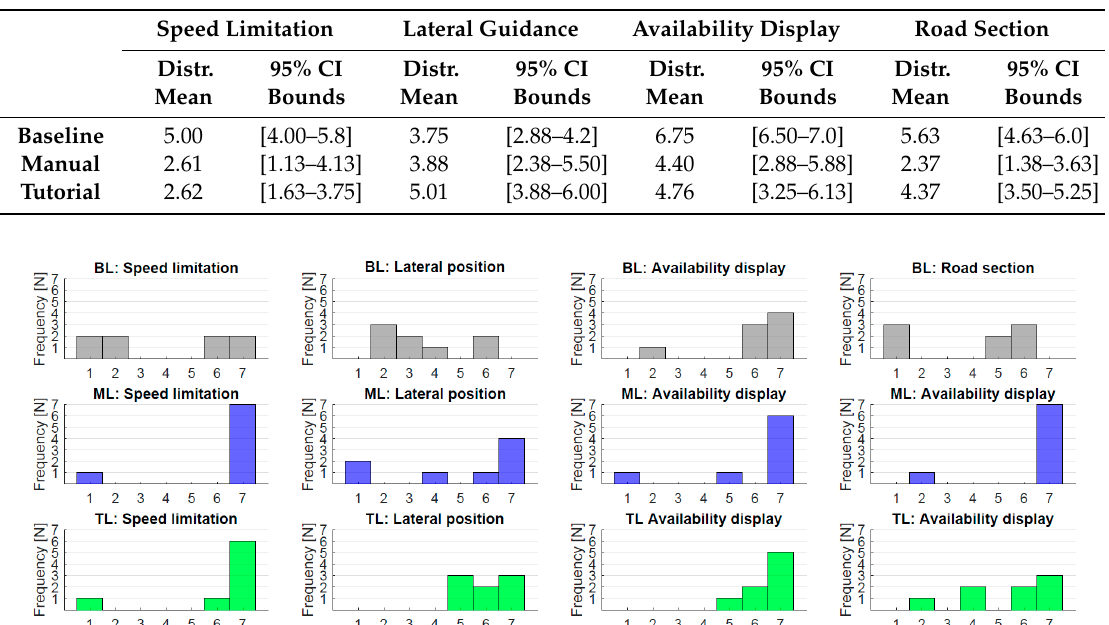
Table 7. Means and 95% CI upper and lower bounds of bootstrapped mental model distributions for the four relevant items on L2 automation by the three experimental conditions.